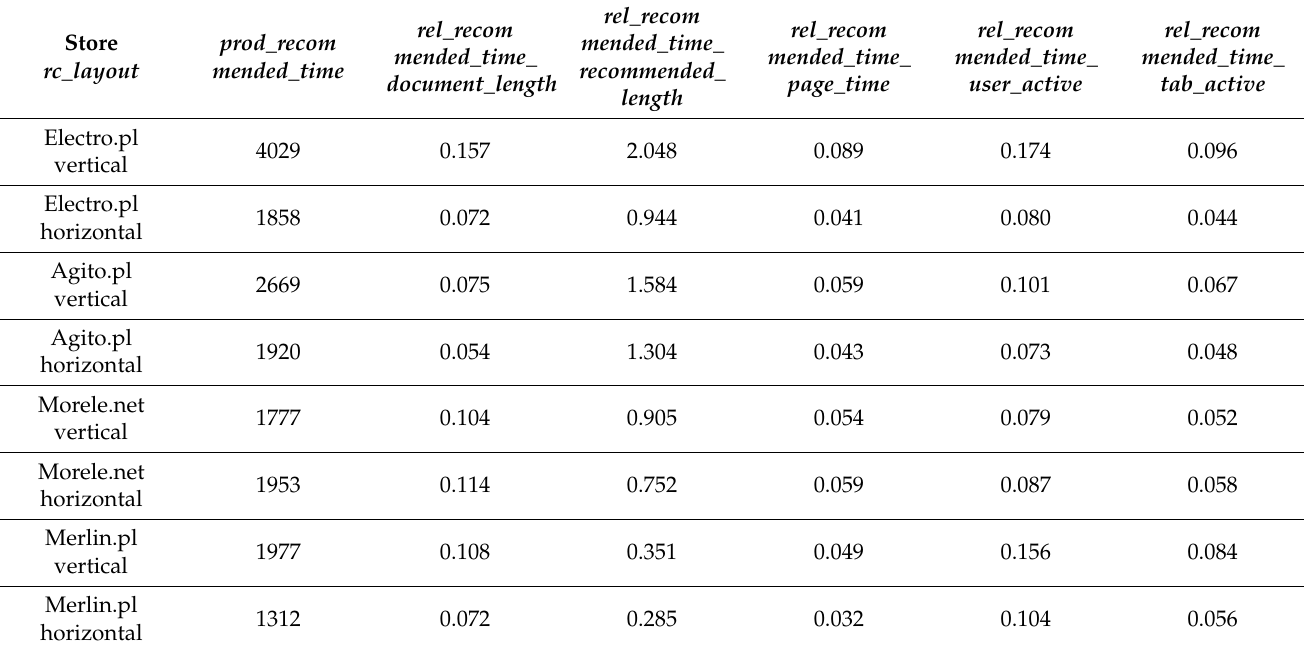
Table 2. Recommending interface quality